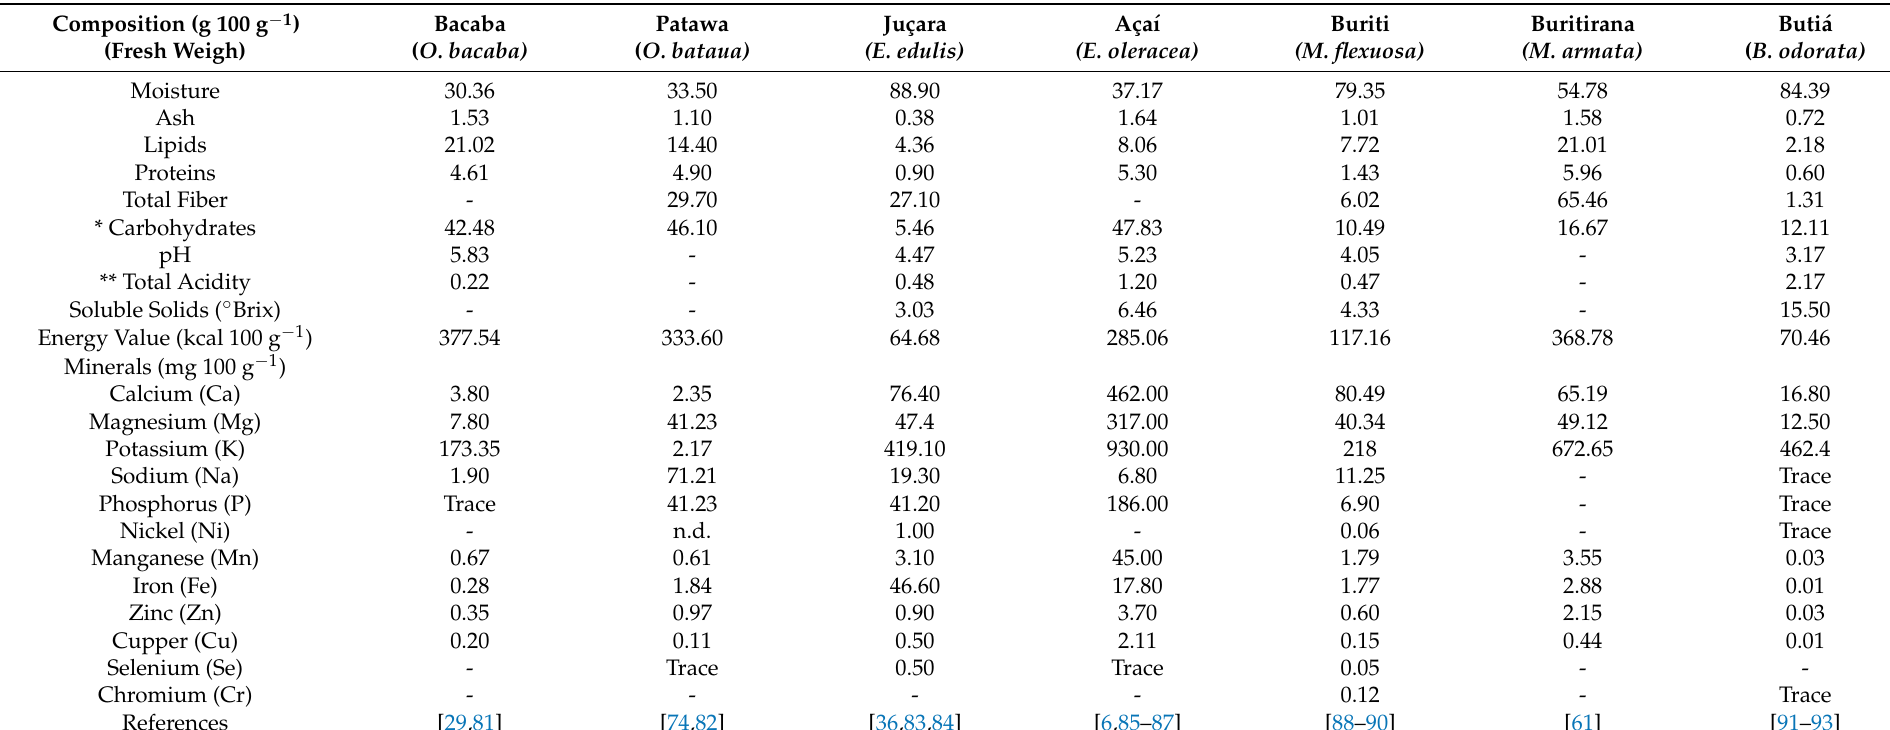
Table 1. Physicochemical characteristics and mineral composition of fruits belonging to the Arecaceae